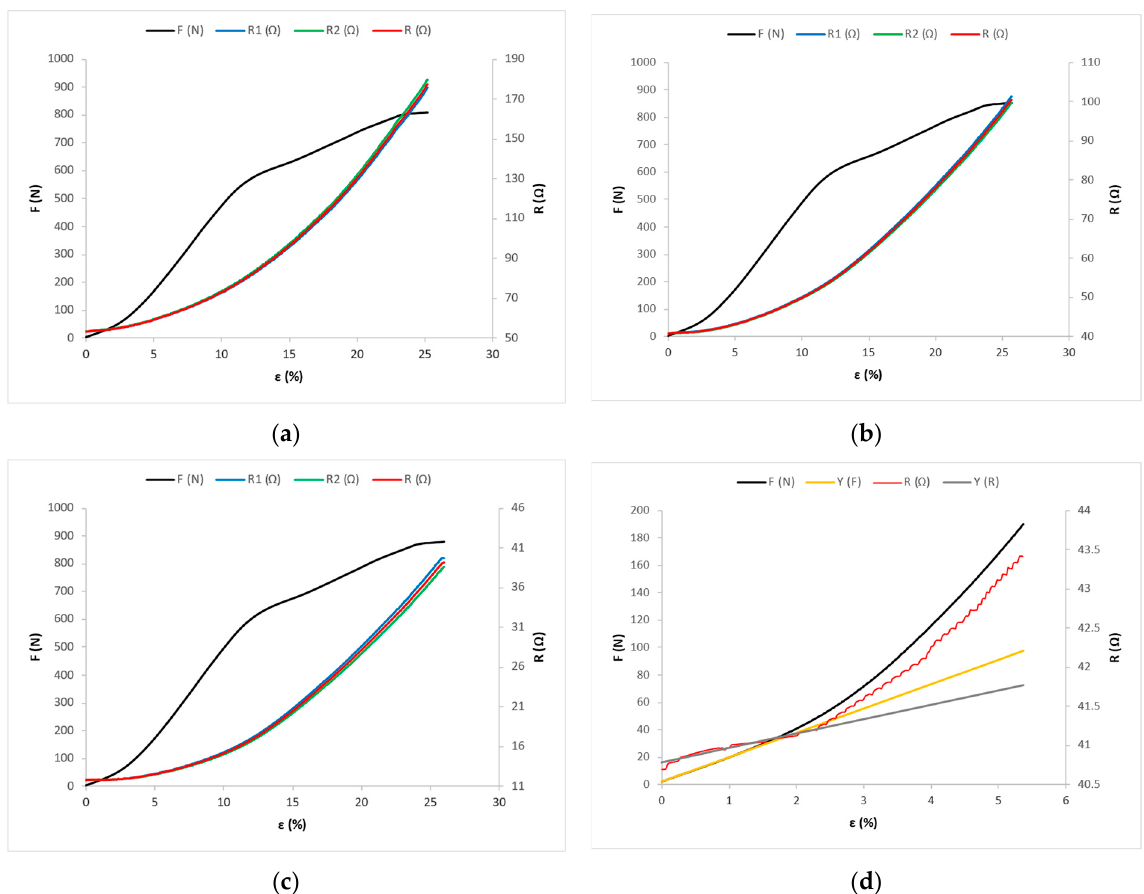
Figure 8. Force–elongation (F- ε ) and electrical resistance–elongation (R- ε ) diagrams for fabric samples cut in the weft direction: ( a ) for sample X-90; ( b ) for sample Y-90; and ( c ) for sample Z-90. ( d ) Experimental and mathematical models of F- ε and R- ε curves for sample Y-90.